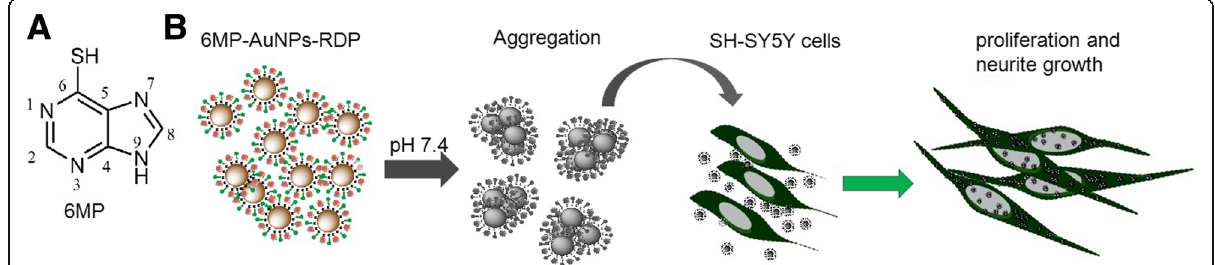
Fig. 1 Scheme of experimental procedure. a 6-Mercaptopurine structure. b Experimental procedure. The particles were synthesized at pH 9.0 and appeared aggregated at pH 7.4. When the particles were added into the SH-SY5Y cell media, they were internalized into the cells and stimulated cell